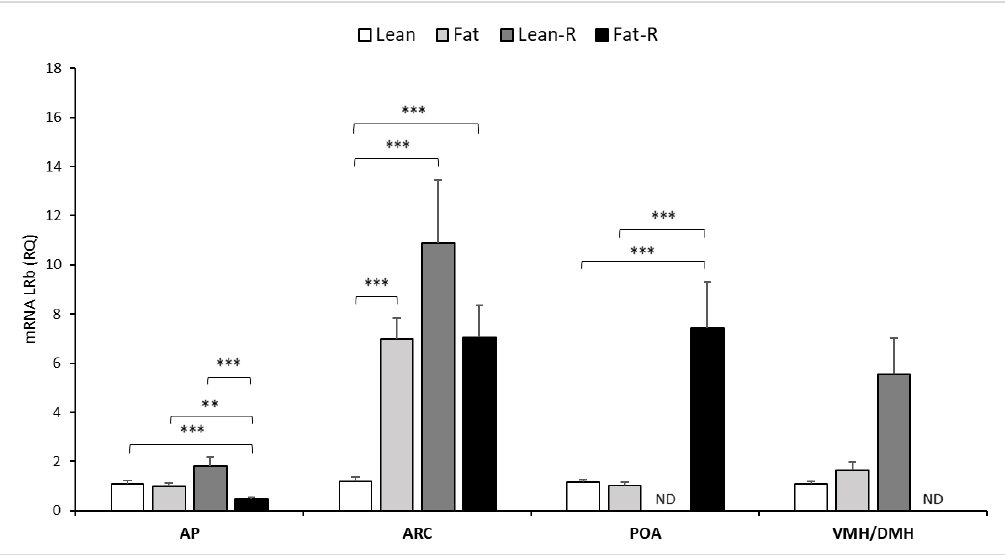
Figure 2. Leptin receptor mRNA expression. The mean mRNA expression ( ± SEM) of the long form of the leptin receptor (LRb) in the ovine anterior pituitary gland (AP), arcuate nucleus (ARC), preoptic area (POA) and ventro- and dorsomedial nuclei (VMH / DMH) collected during a long-day (LD) photoperiod in nontreated (Lean and Fat) animals and animals treated with recombinant bovine resistin (Lean-R [Lean-Resistin treated] and Fat-R [Fat-Resistin treated]. The expression of LRb mRNA is reported in arbitrary units (RQ) relative to cyclophilin mRNA expression and expressed relative to the calibrator sample. Di ff erences relative to the control or between the other groups are indicated with ** p < 0.05, *** p < 0.001. Samples in which the expression of the target gene was undetectable are designated with